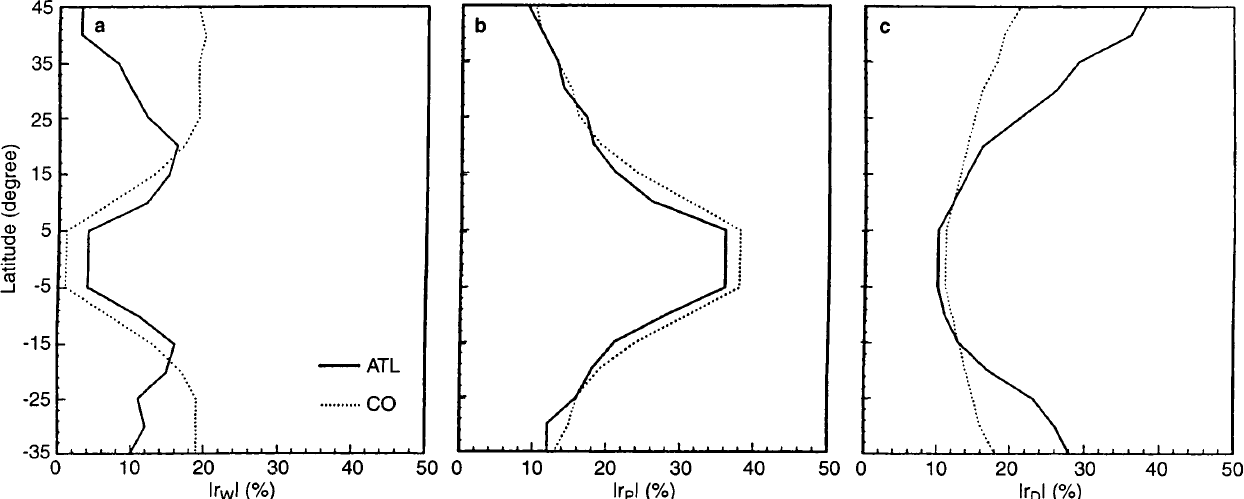
Fig. 8a–c. Linear energy flux coe(cid:129)cient (%) at di(cid:128)erent latitudes (degree). a r meridional boundary ( C0 ). Wave period: 360 days